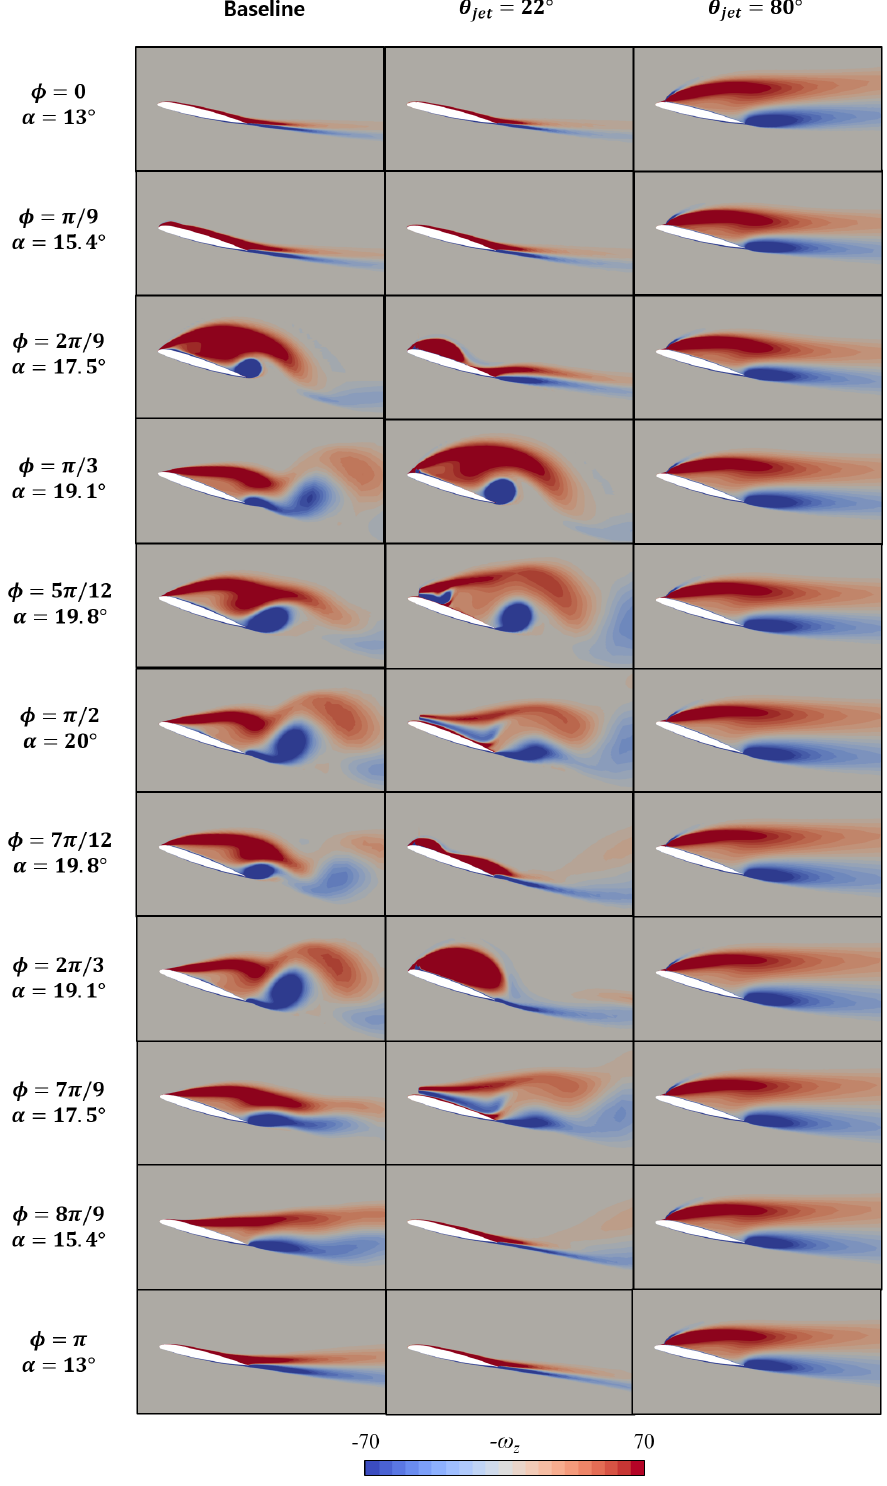
Figure 16. Vorticity ω z field for the pitching OA209 airfoil with and without steady-blowing jets. Ma = 0.3, Re = 1.15 M, c µ = 0.06, k = 0.05 and α = 13 ◦ ± 7 ◦